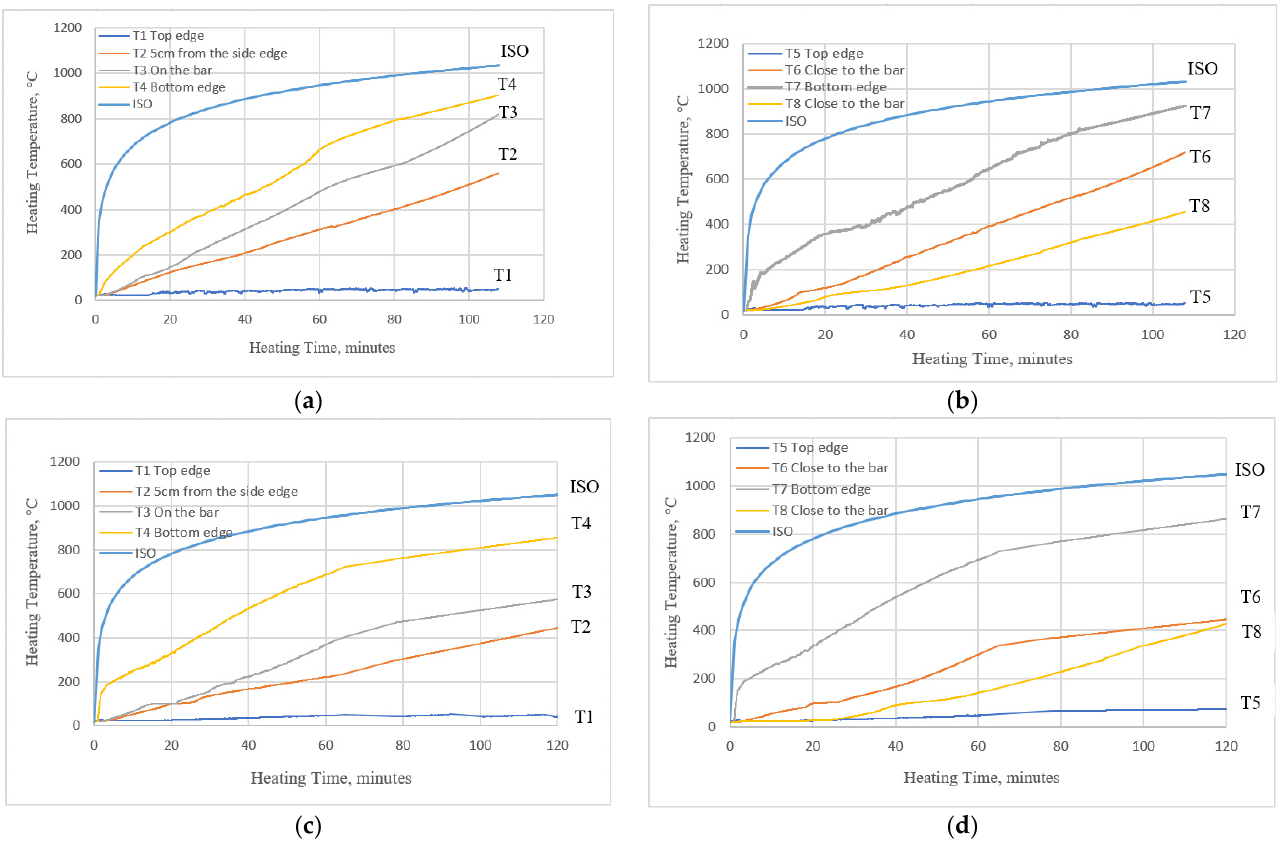
Figure 8. Measurements from the embedded thermocouples: ( a ) B2Ø14, location A; ( b ) B2Ø14, locations B and C; ( c ) H2Ø14, location A; ( d ) H2Ø14, locations B and C.